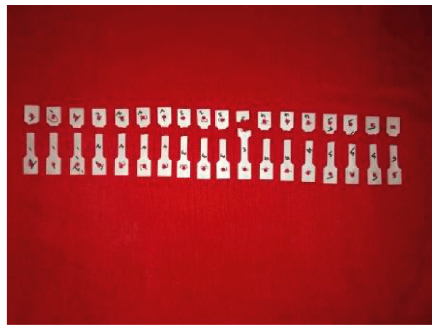
Figure 5: Fatigue test samples as per ASTM.